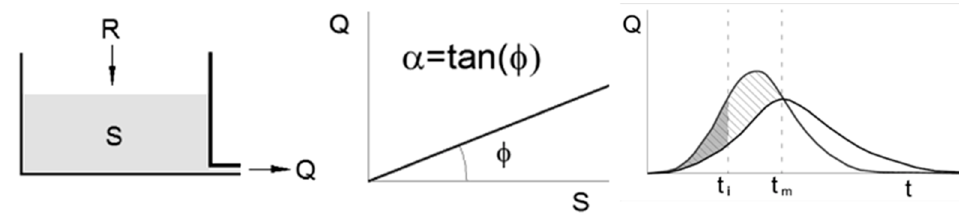
Figure 2. Water routing for a linear reservoir.